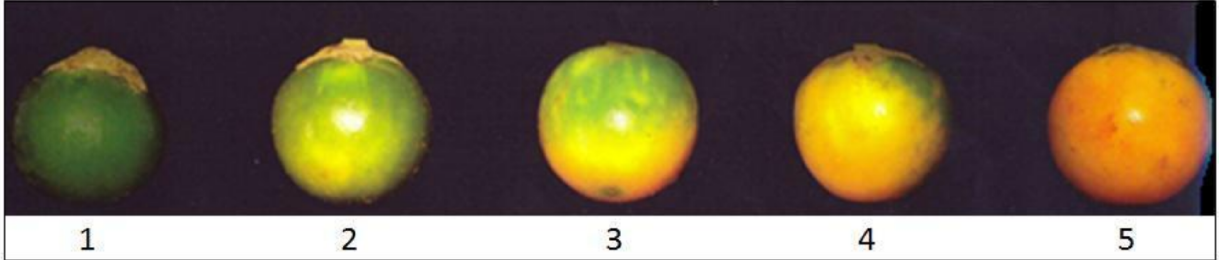
Figure 1. Naranjilla maturity degrees according to [13]. Note change of color, fruits are harvested at category number 4 for commercial